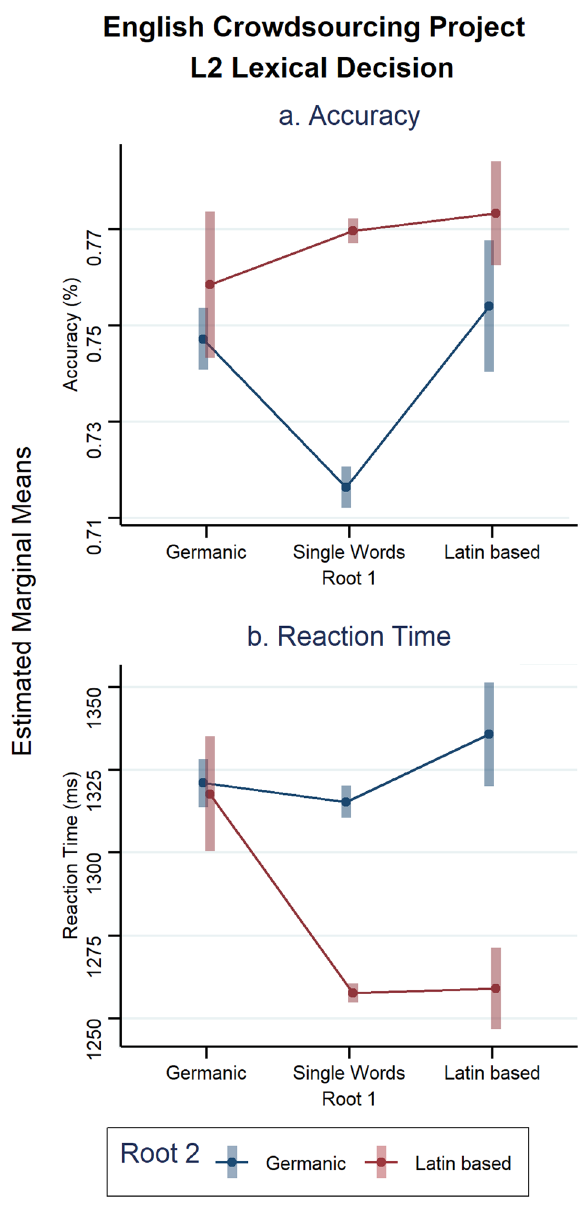
Fig. 5 English Crowdsourcing Project L2: interaction for lexical decision task for accuracy (%) and reaction time